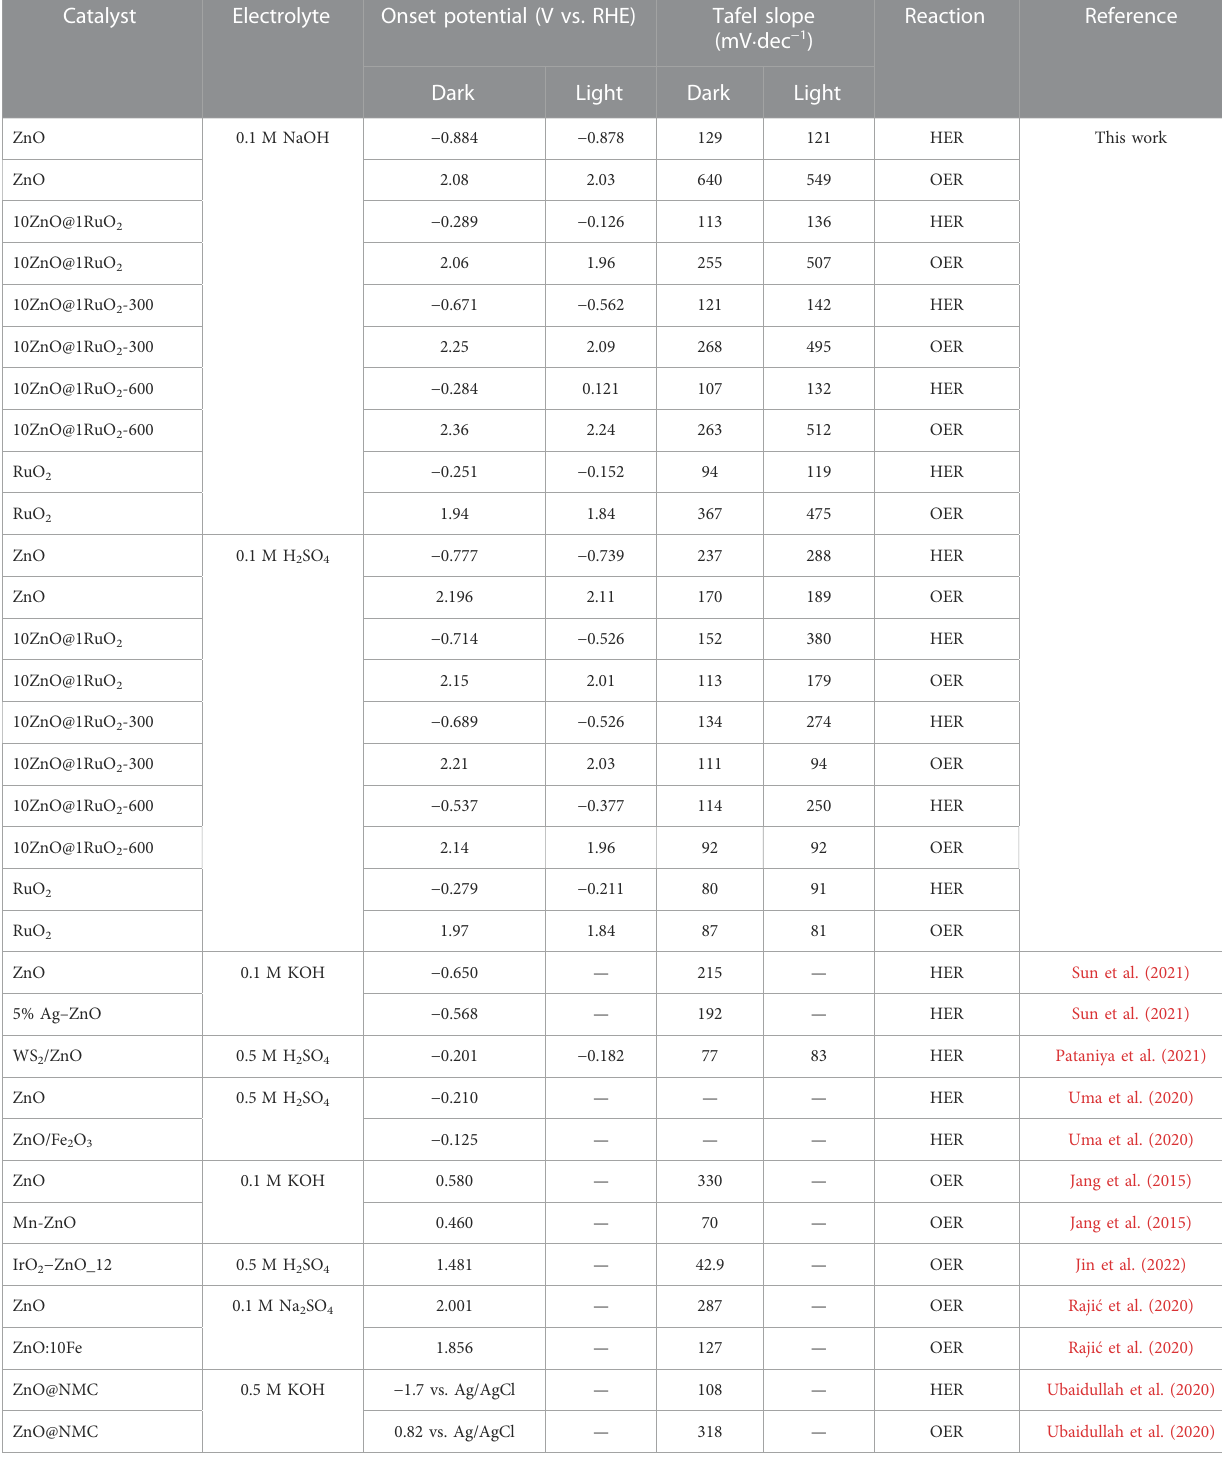
TABLE 2 Onset potentials (V vs. RHE) and Tafel slopes (mV · dec − 1 ) of the tested catalysts toward HER and OER in alkaline and acidic media in the dark and after 60 min of light irradiation compared to literature data for different ZnO-based photocatalysts. Catalyst